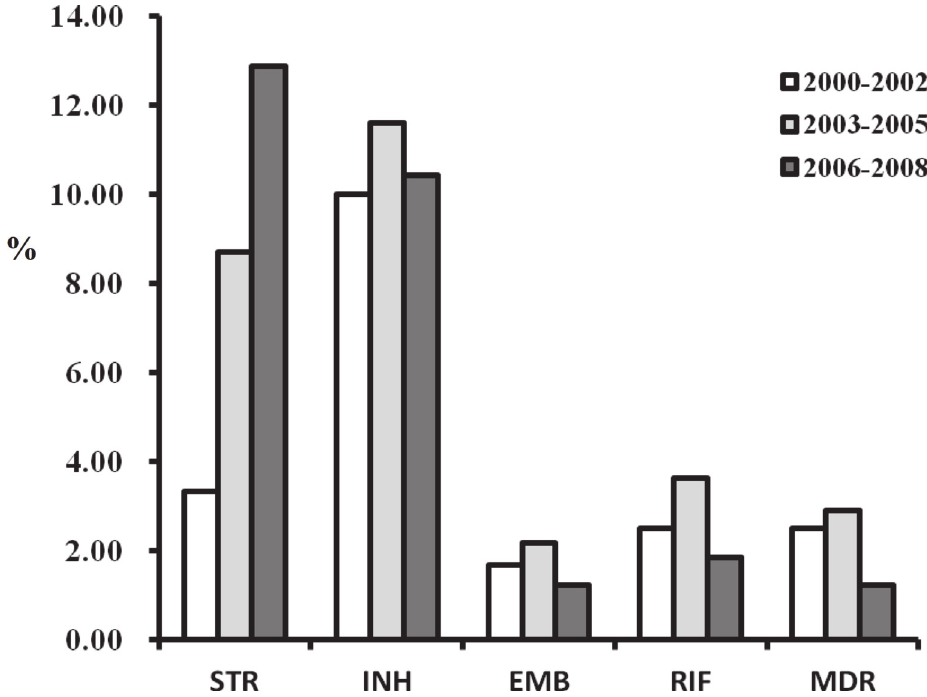
Figure 2. Overview of the dynamic changes in drug-resistance patterns in all MTB strains isolated from 421 patients. found in the rpsL gene in these low-level STR-resistant MTB strains (Table 3). These results suggest that low-level STR resistance might be caused by mutation of the gidB gene. However, the existence of 2 low-level STR-resistant strains showing no mutation in any of gidB, rpsL and rrs suggests there must also be other mechanisms for STR resistance. Of the 20 high-level STR-resistant strains, 14 (70.0%) were found to carry a nonsynonymous mutation in the gidB gene and 16 were found to have a nonsynonymous mutation in the rpsL gene (Table 3). Among the 14 rpsL mutants the most frequent mutation was K43R (9/14; 64.3%), followed by K88R (3/14; 21.4%) (Table 3). The most frequently paired gidB and rpsL double mu-